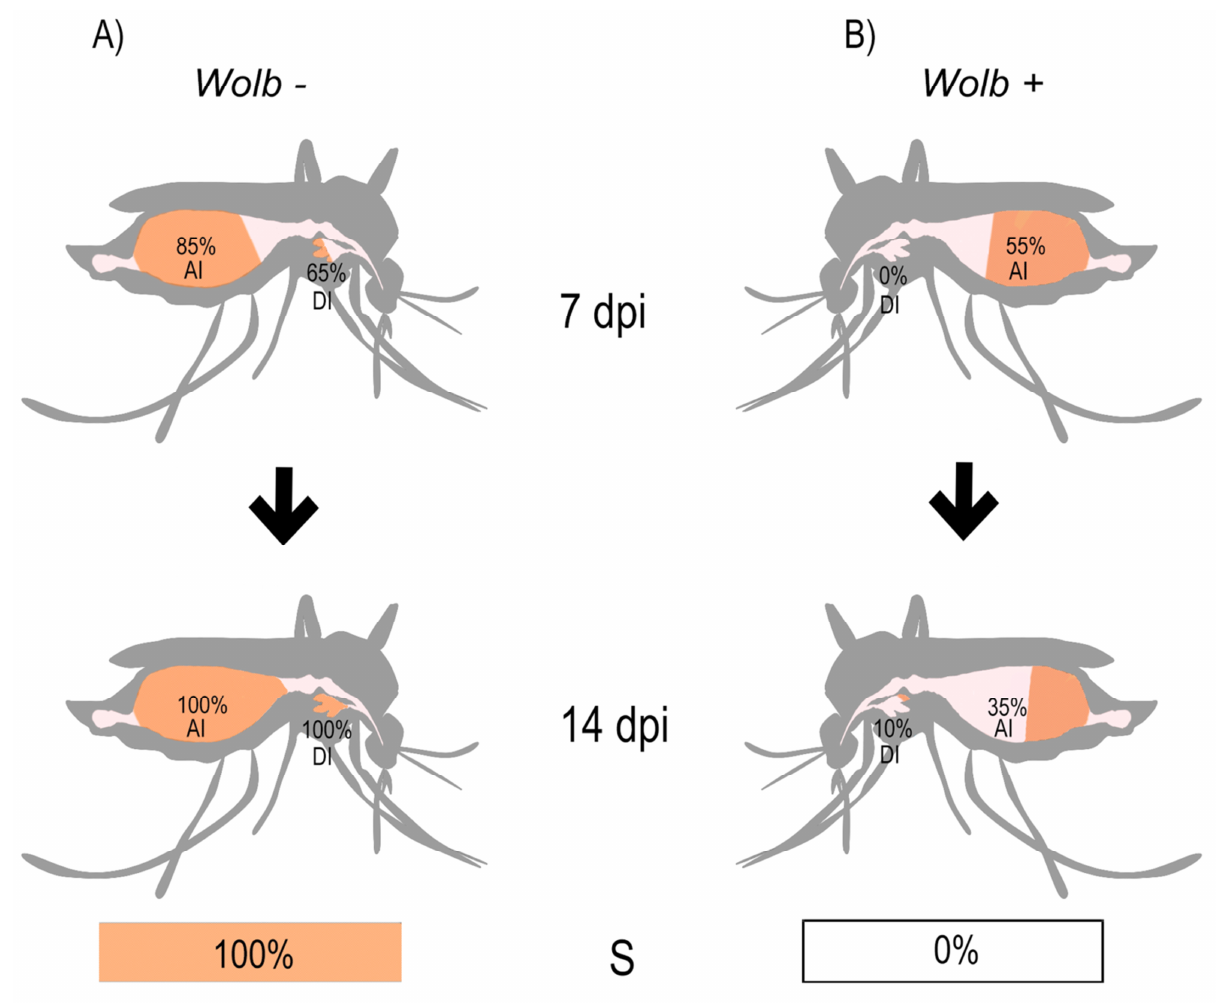
FIGURE 1: Schematic depicting the prevalence of Zika virus infection in Wolbachia -uninfected (A, Wolb - ) and Wolbachia -infected (B, Wolb +) Aedes aegypti . Data for the BRPE ZIKV isolate were obtained through RT-qPCR analysis. Percentage values represent abdominal infection rates (AI), and disseminated infection rates (DI) at 7 and 14 days post-infection (dpi), or rate of subsequent infection after saliva was injected into naïve Wolbachia -uninfected mosquitoes at 14 dpi